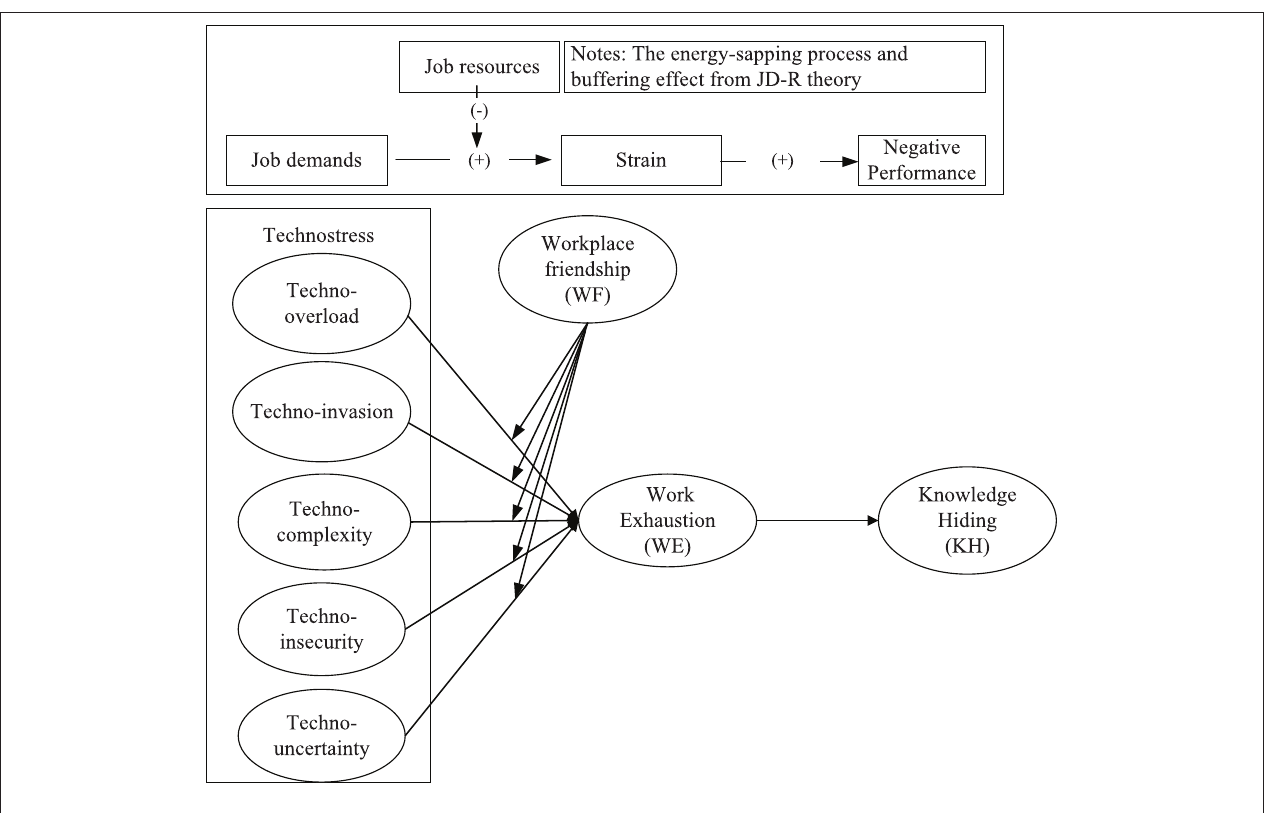
FIGURE 2 | Conceptual